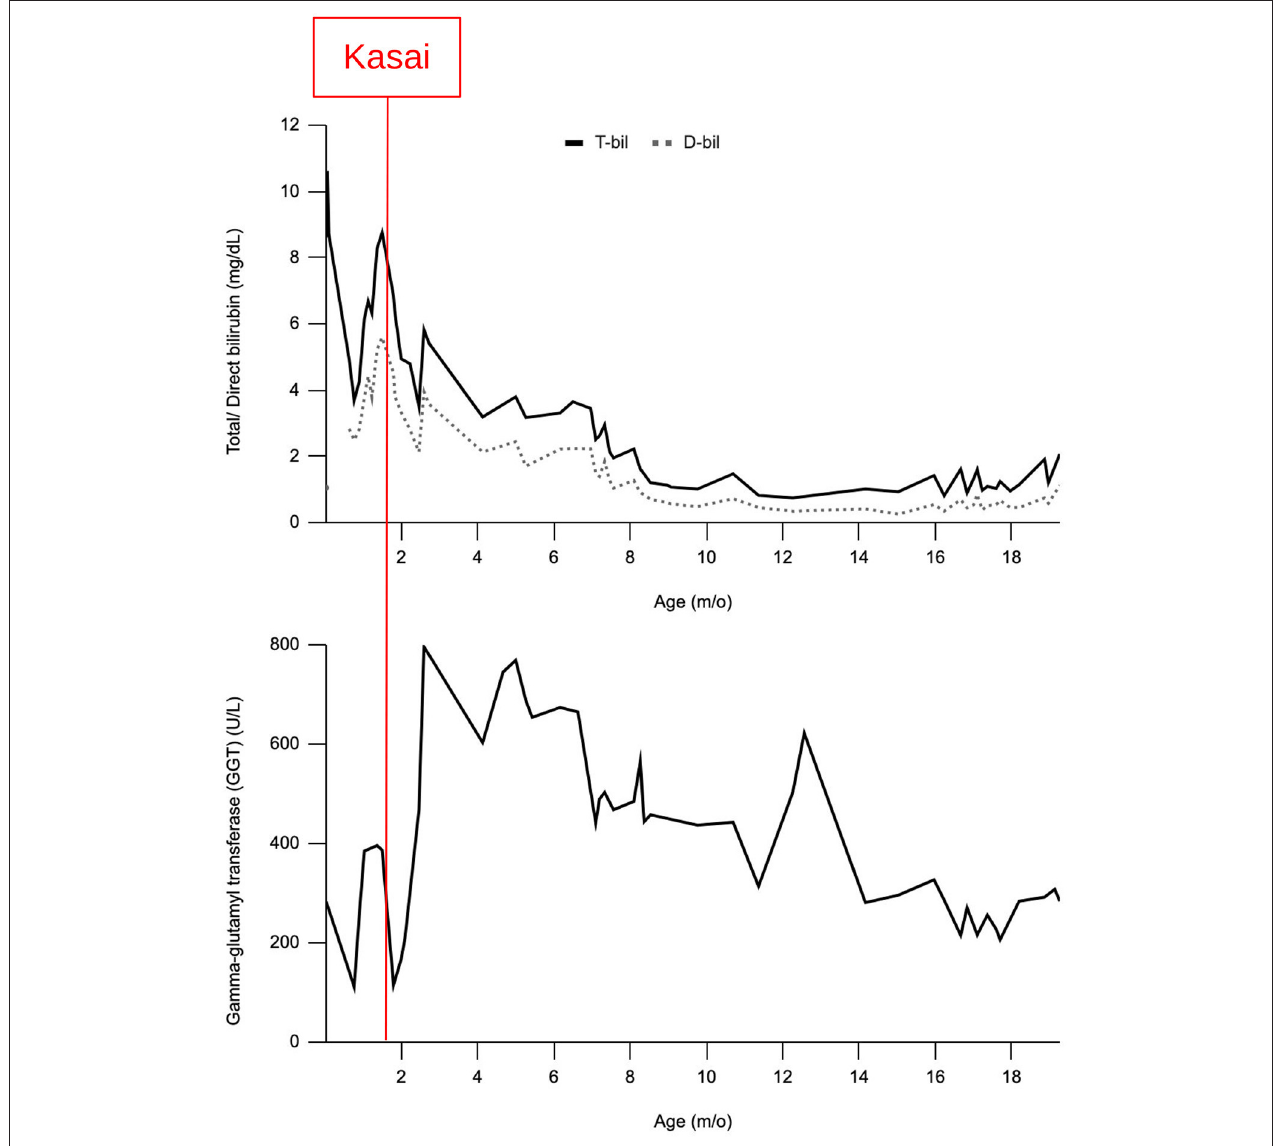
FIGURE 2 | Serum biochemistry [Gamma-glutamyl transferase (GGT)/total and direct bilirubin] from birth to the latest follow-up. Operation day was marked with the red